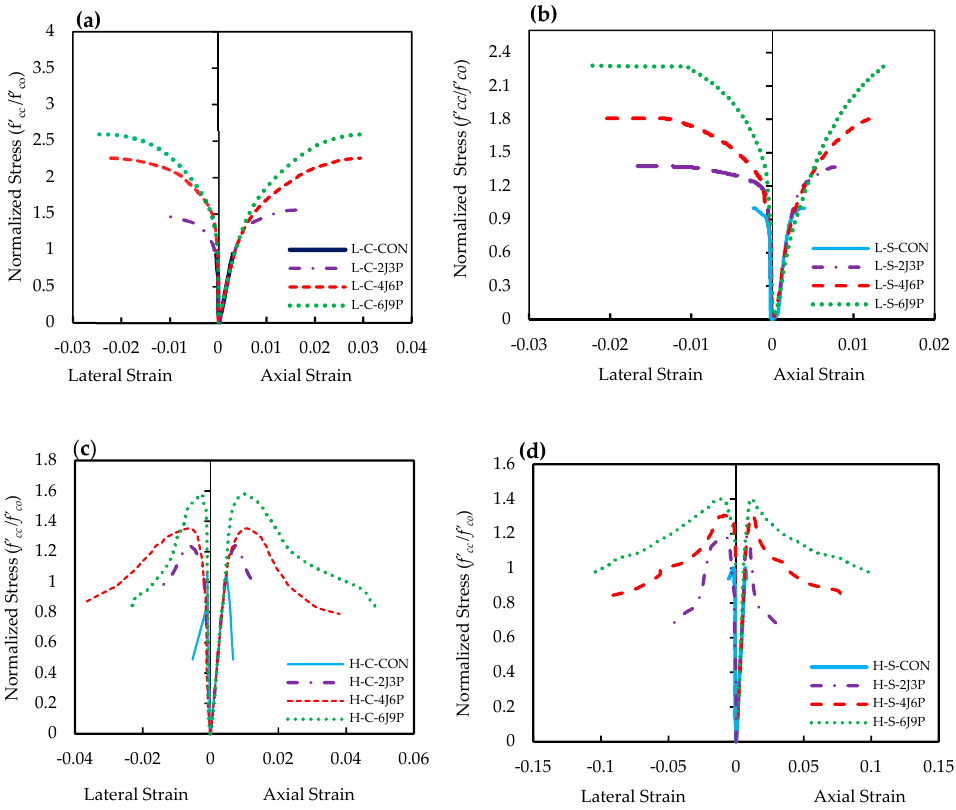
Figure 10. Stress-strain curve behavior of confined columns: ( a ) Low-strength circular specimens; ( b ) low-strength square specimens; ( c ) high-strength circular specimens; and ( d ) high-strength square specimens.